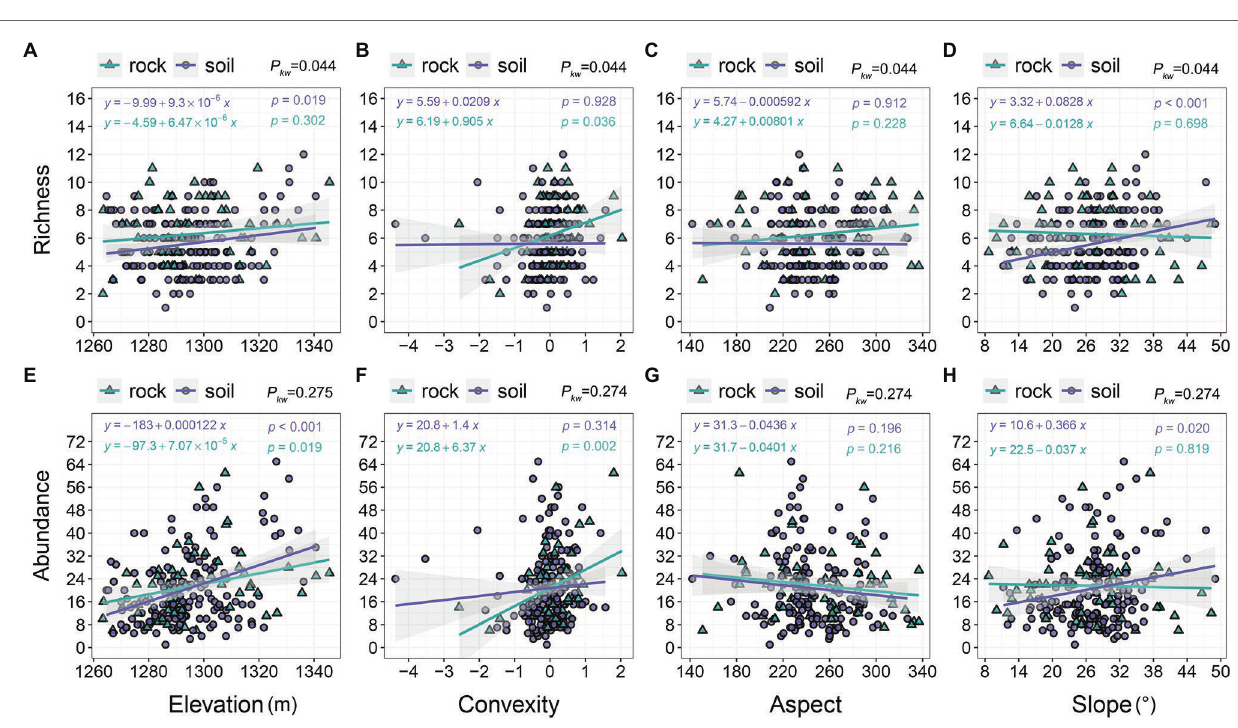
Figure 8A ). With respect to site type, slope was positively correlated with the DBH and TH of trees growing on rock,